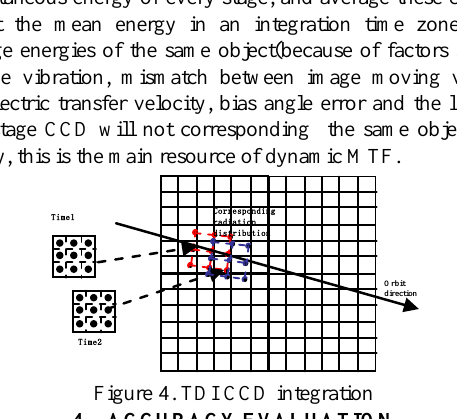
Figure 5. Worldview-2 DSM